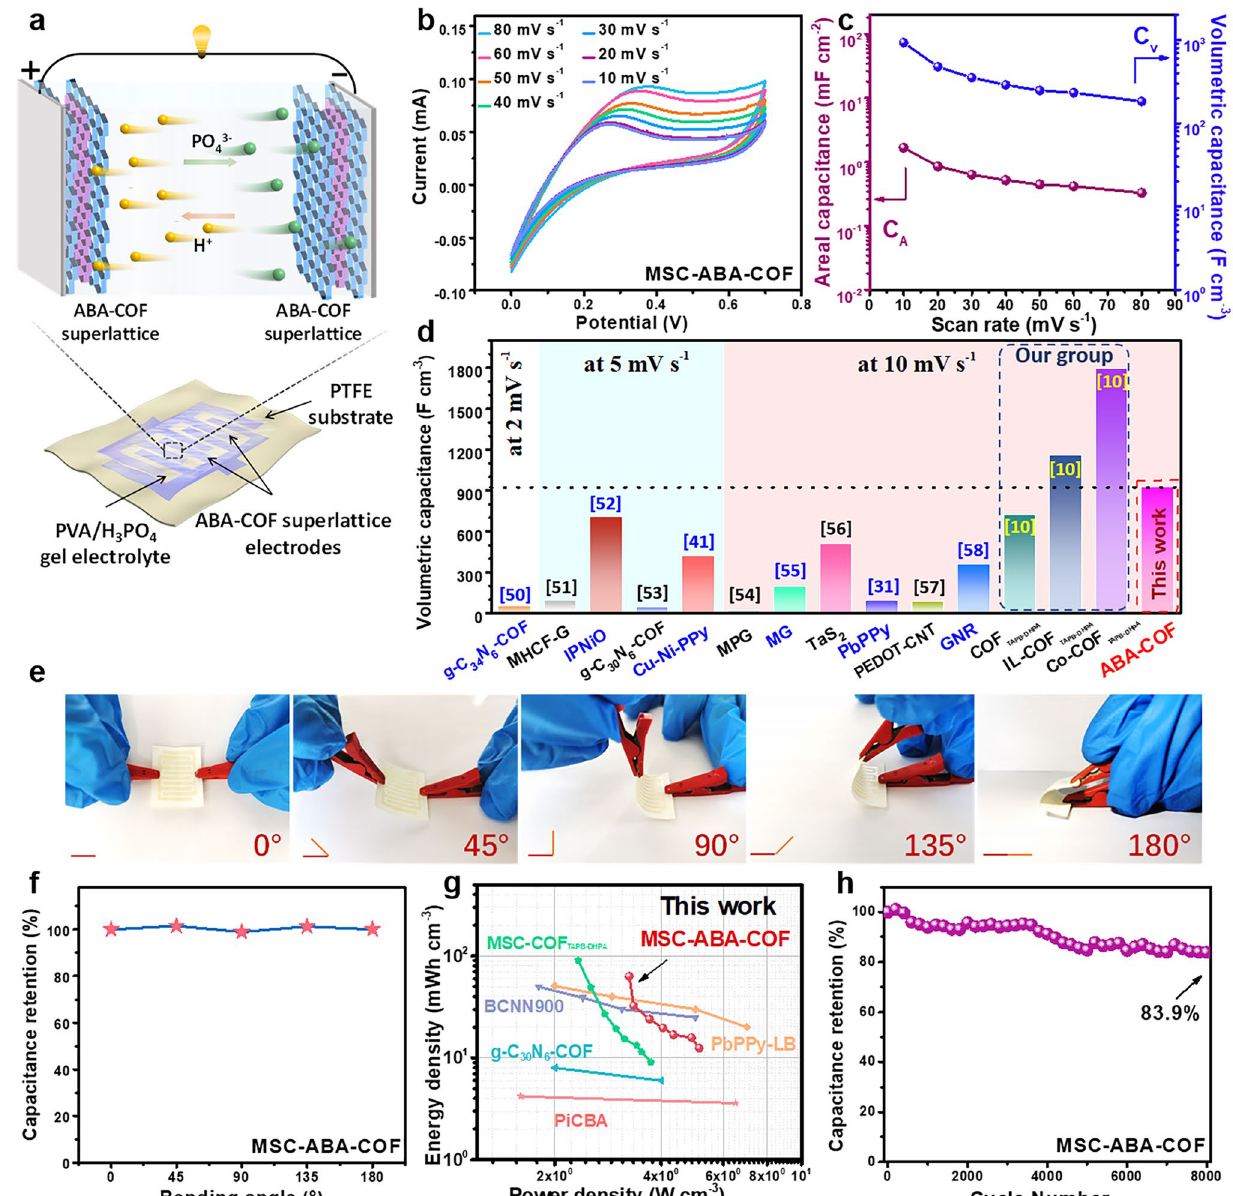
Fig. 3 a Schematic diagram of the in-plane MSC configuration. b CV curves, c C A and C V of MSC–ABA–COF. d C V comparison with some reported MSC devices. e Optical photographs and f capacitance retention under different bending degrees of MSC–ABA–COF. g Ragone plots of MSC–ABA–COF, as well as some reported MSC devices. h Cycling stability of